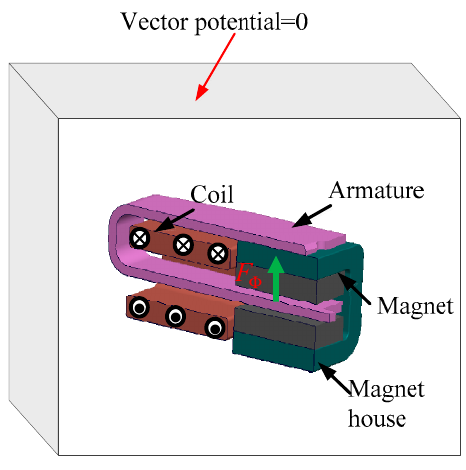
Figure 9. Modeling of electromagnetic FEM simulation.